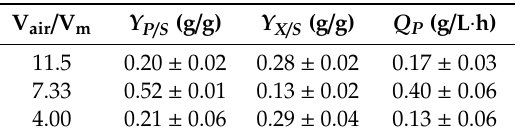
Table 5. Fermentation parameters obtained during the production of itaconic acid by A. terreus from cellulose pulp hydrolysate under di ff erent aeration